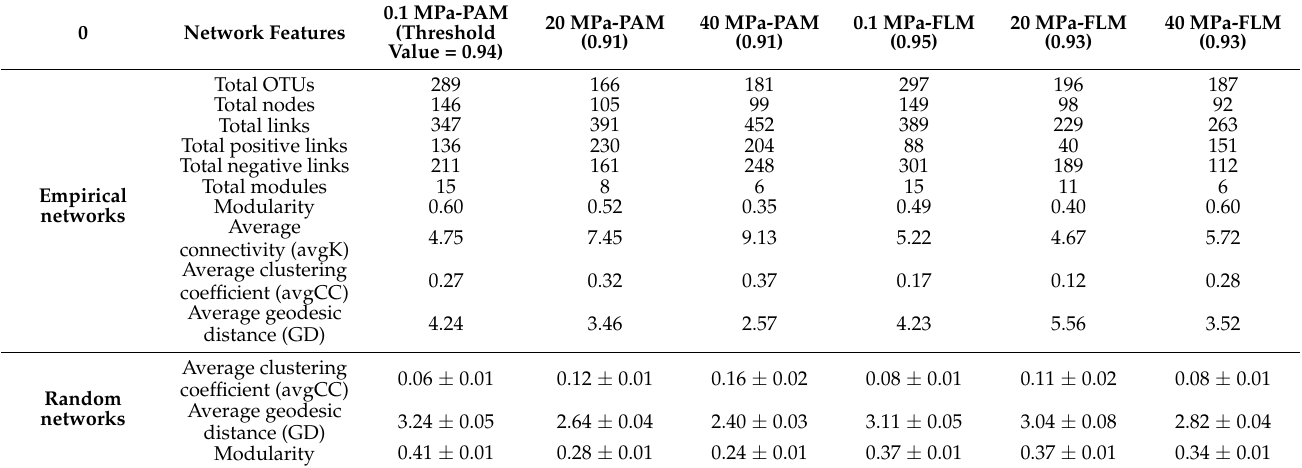
Table 1. The topological properties of the co-occurrence networks for the PAM and FLM communities at 0.1, 20, and 40